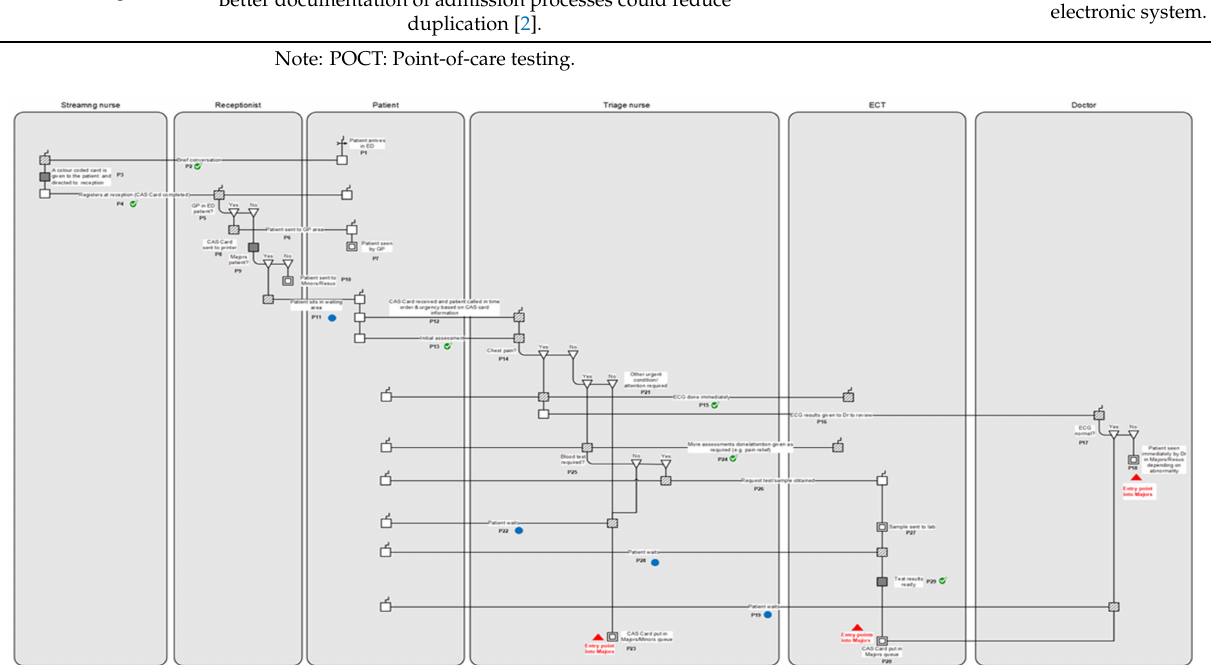
Figure 3. RAD of information collection points prior to entry into Majors (self-presenting patients). Note: Self-presenting patients are triaged and sent to the Majors unit if